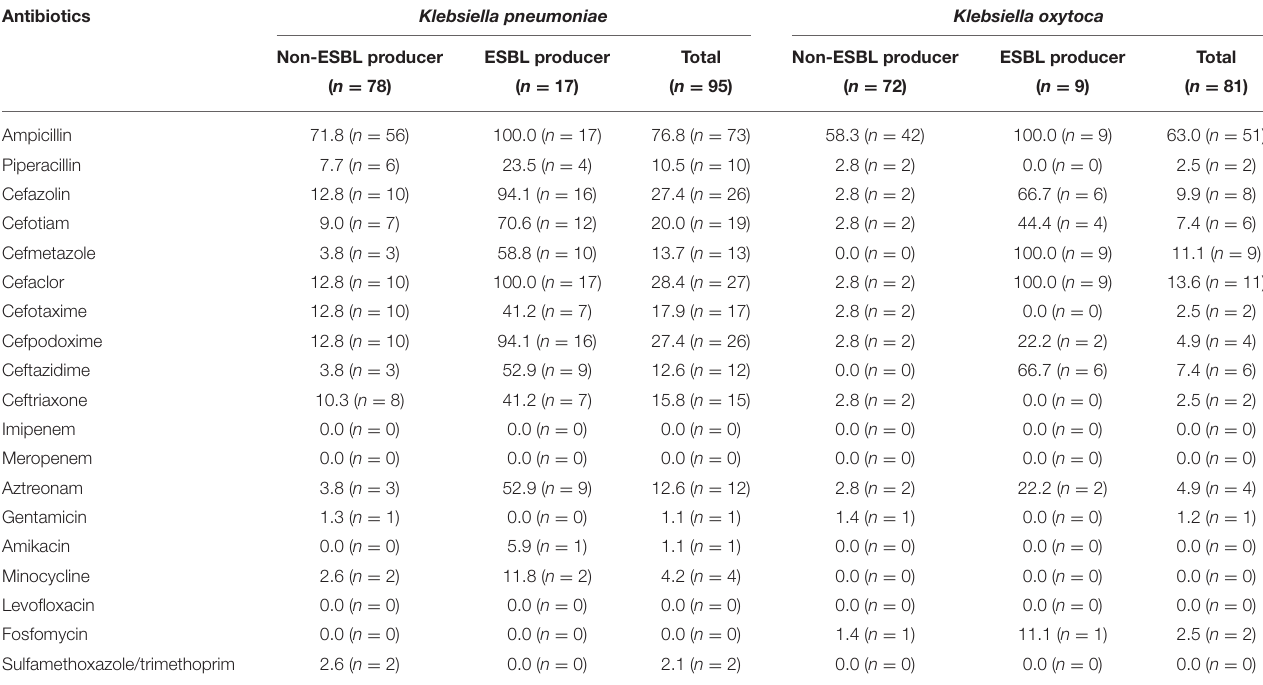
TABLE 1 | Proportion (%) and number of drug-resistant isolates of Klebsiella pneumoniae and Klebsiella oxytoca . Antibiotics Klebsiella pneumoniae Klebsiella